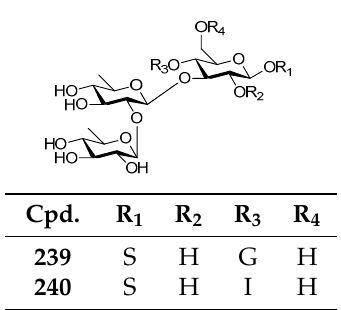
Figure 46. Structures of compounds 235 – 238 .